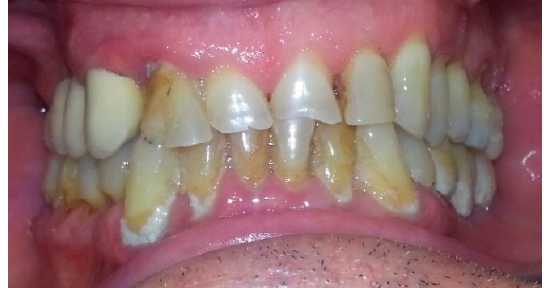
Figure 1. Frontal view of patient intraoral in first visit.